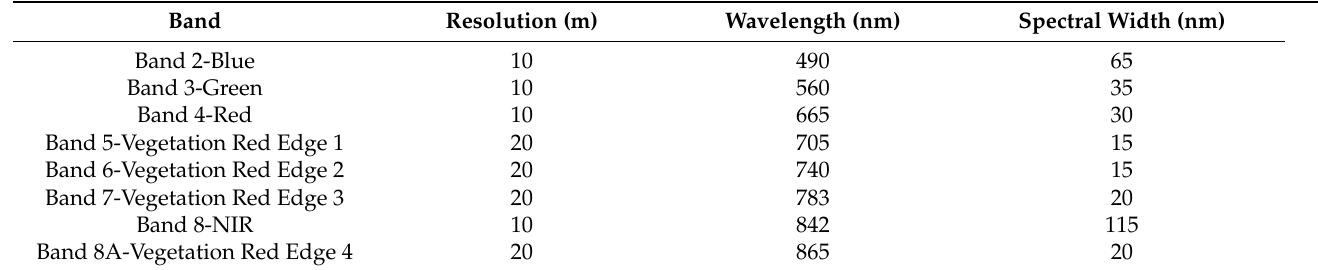
Table 5. Sentinel-2